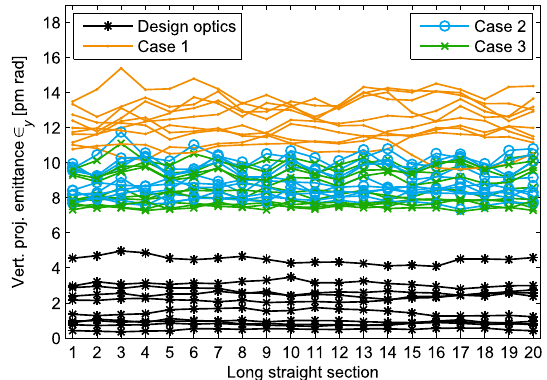
FIG. 9. Vertical projected emittance ϵ y (solid lines) and vertical eigenemittance E (dashed lines) in the ideal lattice for the three II cases. (Markers are displayed for Case 1 since traces partially overlap.)